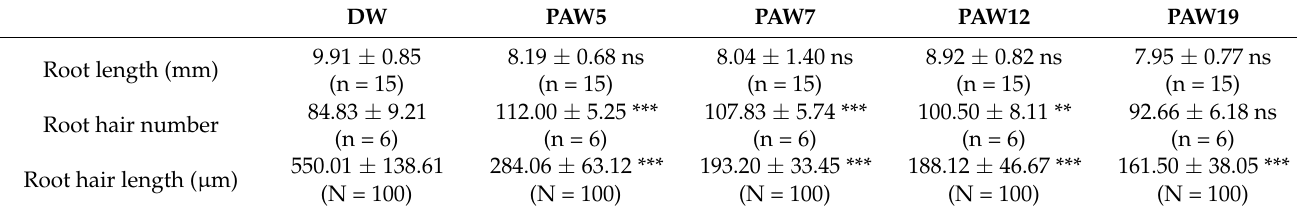
Table 2. Total root length, root hair number and root hair length A. thaliana L. (Col.0) 5 days after planting.